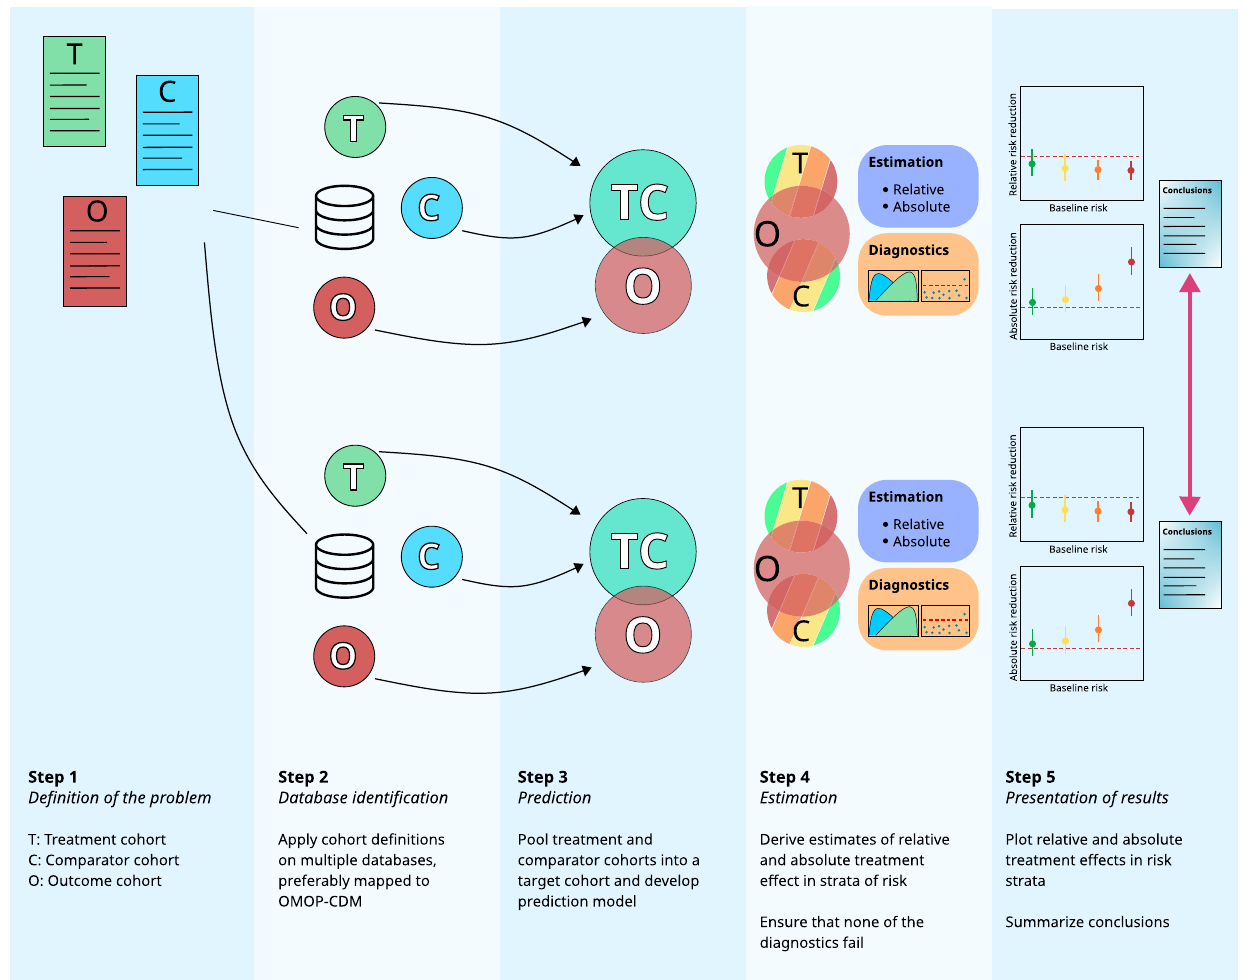
Fig. 1 Framework overview. Illustration of the framework ’ s application on two observational databases, preferably mapped to